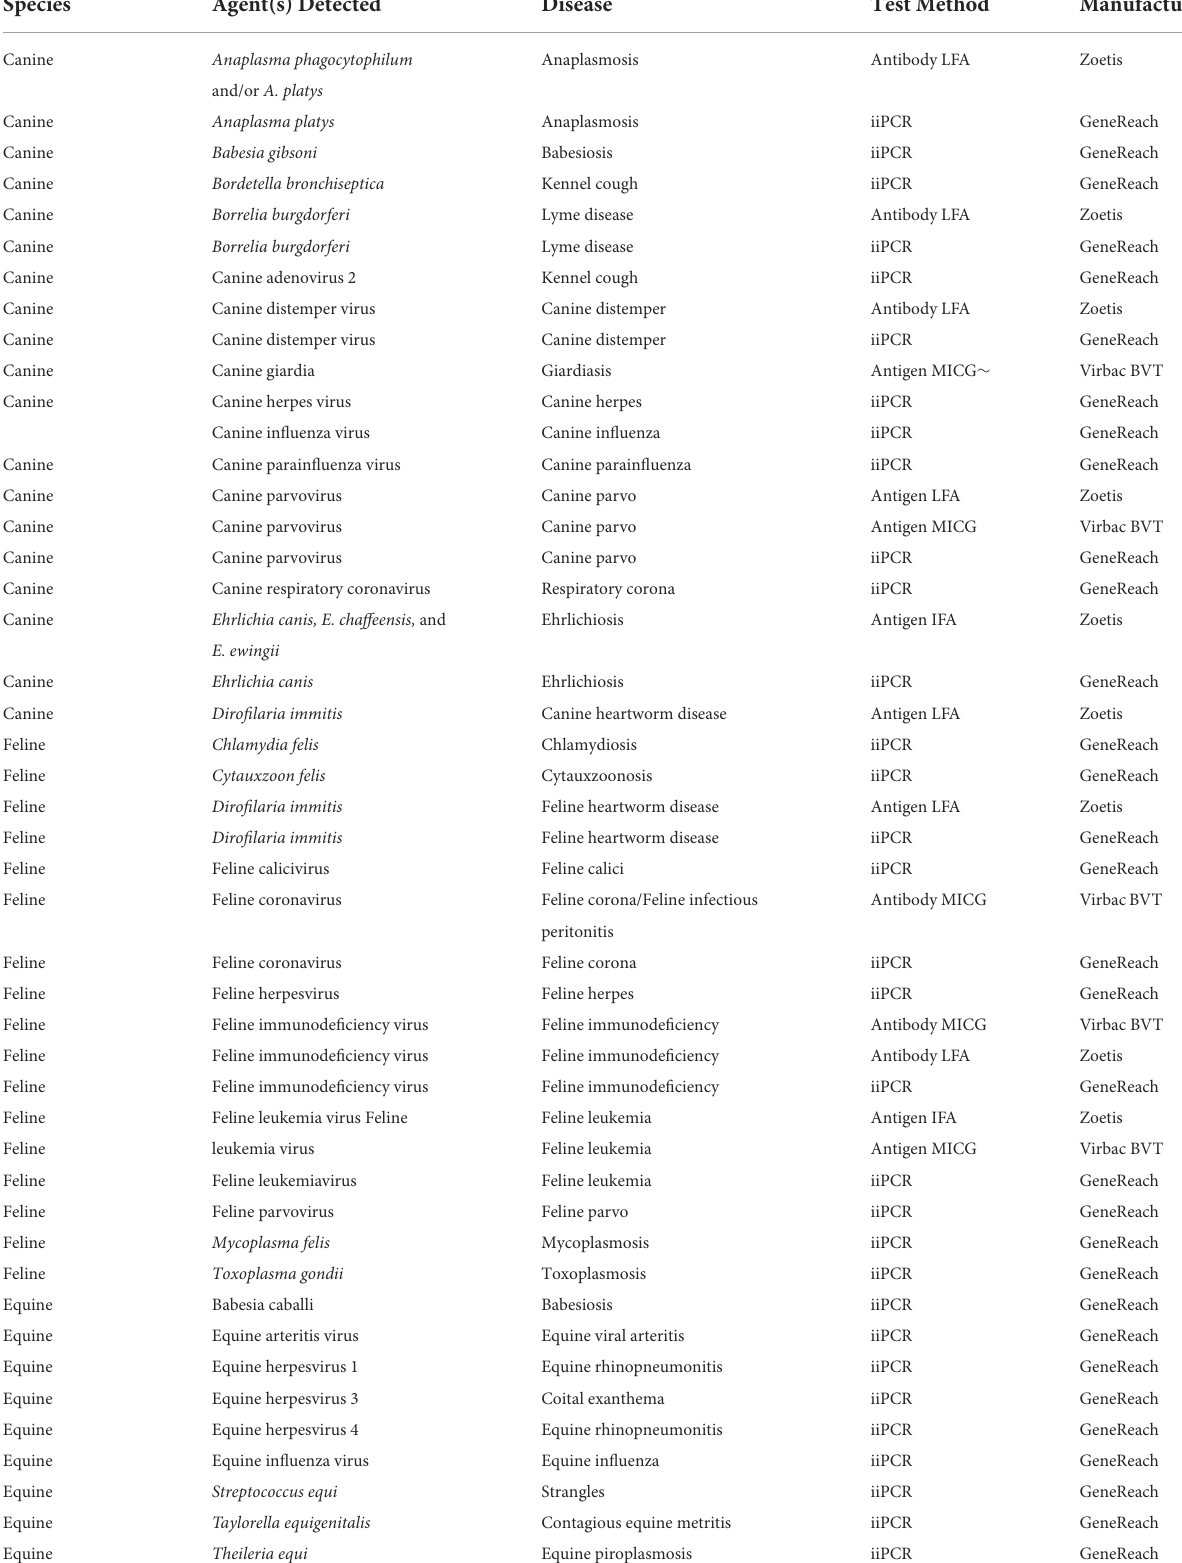
TABLE 1 Commercially available POCT diagnostics for infectious diseases of companion animals ⋄ . Species Agent(s)